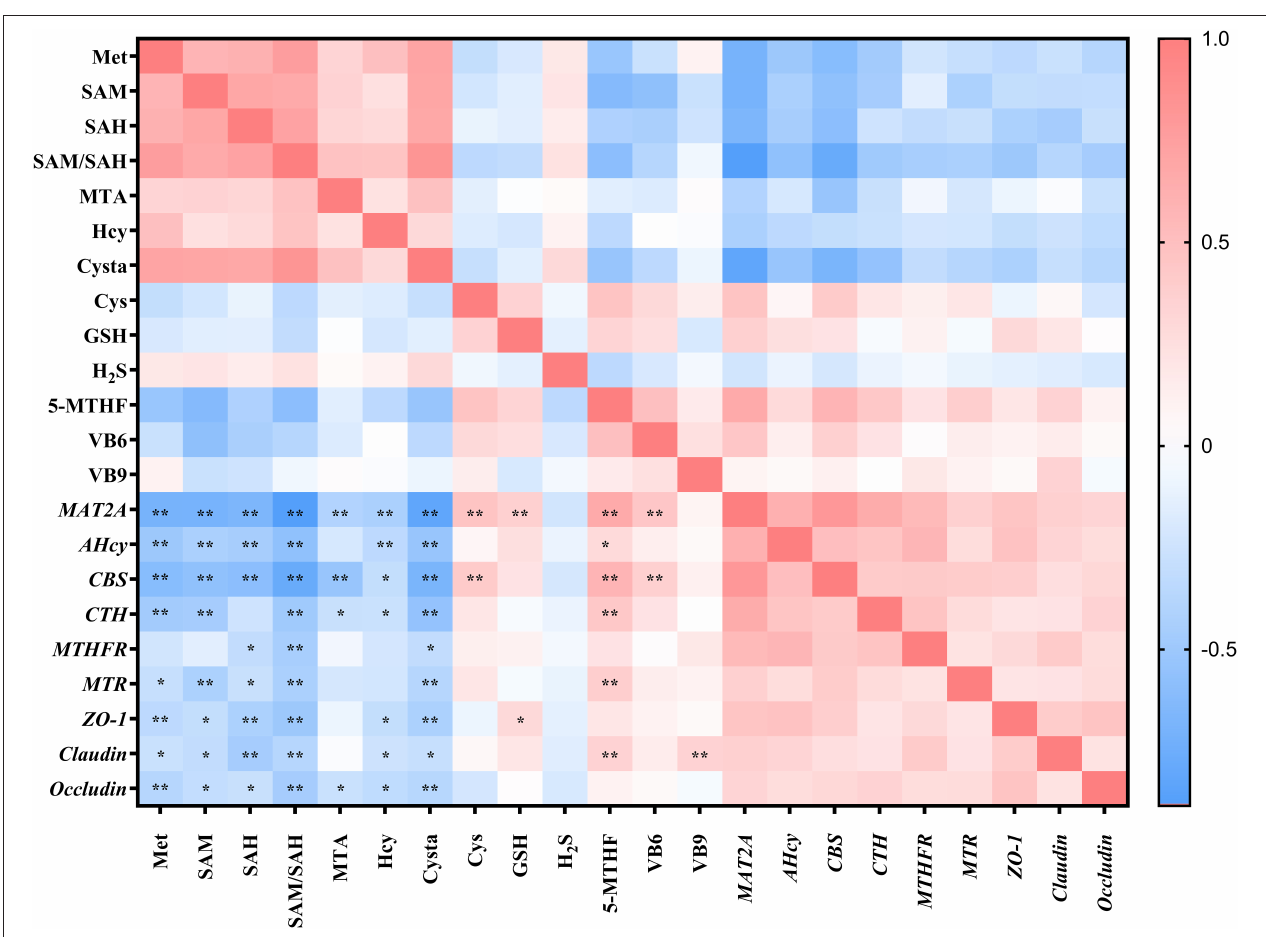
FIGURE 4 | Correlation analysis between methionine metabolites and gene expression levels in IPEC-J2 cells. Cells were cultured without fetal bovine serum for 18h and then without Met for 6h, then, different ratios of L-Met and DL–HMTBA were given for 2h (total methionine source concentration is 5mM). * p < 0.05; ** p <